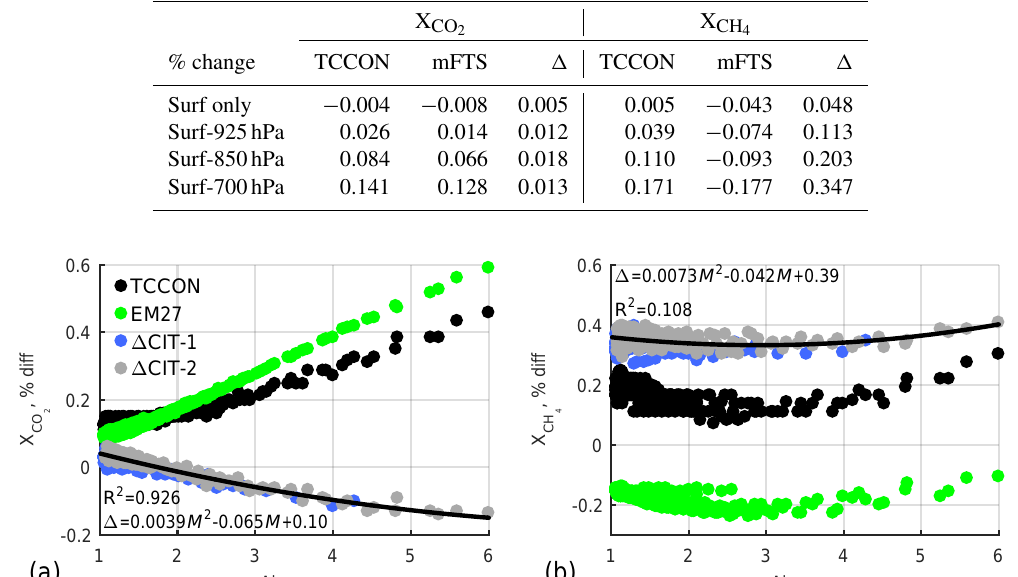
(a) and X CH (b) to a + 10K change in the planetary boundary layer (surface– 2 4 the TCCON–EM27 differences are small (<0.15%) but air mass dependent. For 2 surface temperature error 2